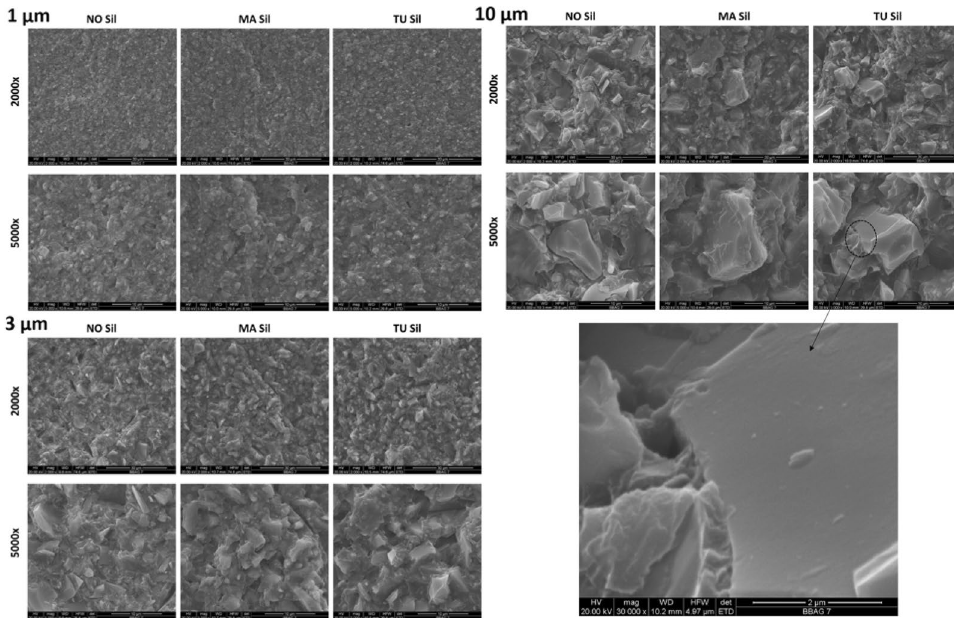
Figure 5. SEM micrographs of fractured surfaces of fracture toughness bars filled with 70 wt% filler particles of 1 µm, 3 µm, and 10 µm size under 2000 × and 5000 × magnifications. In general, NO-Sil formulations were characterized predominantly by uncoated particles completely disconnected from the organic matrix with several areas indicating detachment of particles. In MA-Sil systems most particles are evenly coated by the organic matrix. TU-Sil groups show intermediate characteristics, with particles that were completely uncoated and others seemingly intimately bonded to the organic matrix, as highlighted in micrograph under 30,000 × magnification. It also appears that the TU-Sil fractured surfaces are more distinct, and less “blurry”, unlike in the MA where the crack seems to propagate through the matrix predominantly with the filler well bonded to the resin. The TU shows less bonding in